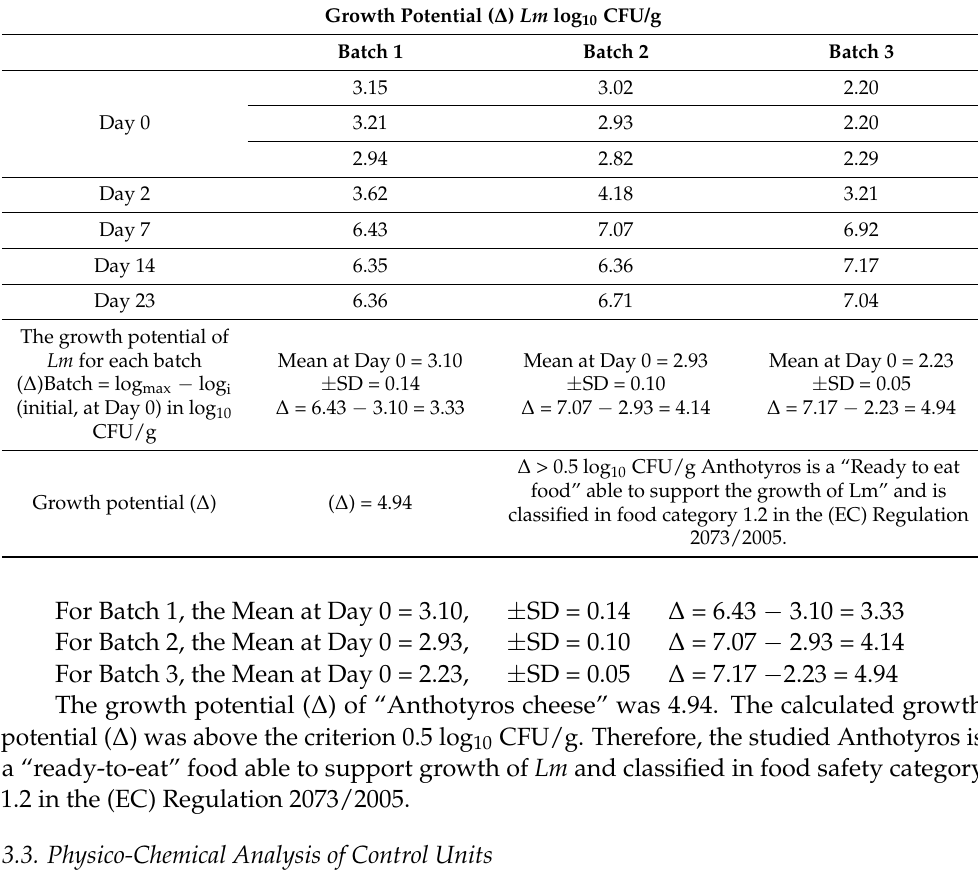
Table 4. Determination of growth potential ( ∆ ).